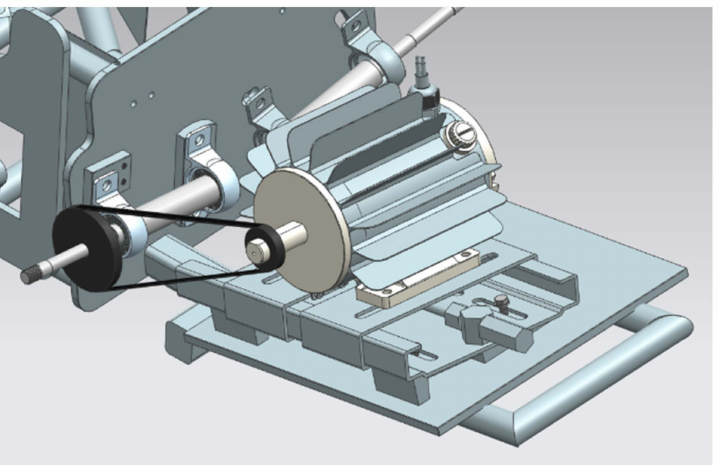
Figure 1. Geometry of the suspension and drive shaft of the electric vehicle of the Silesian Greenpower